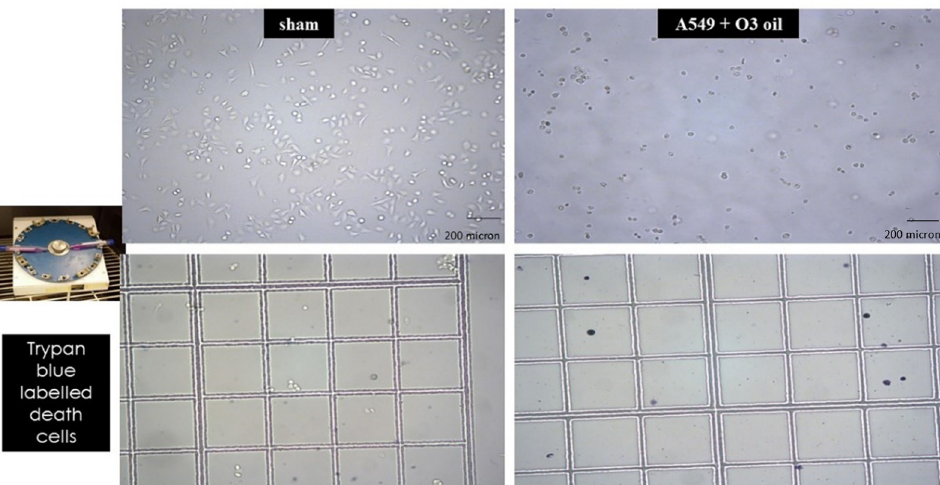
Figure 3. Detection of non-viable cells by Trypan blue staining after 24 h since seeding of A549 cancer cells, either sham-treated with sunflower seed oil (left panels) or treated with ozonide oil >700 ozonides (right panels). Upper panels, standard microscopy; lower panels microscopy after Trypan blue staining. Death cells are detected only in ozonide oil treatment.